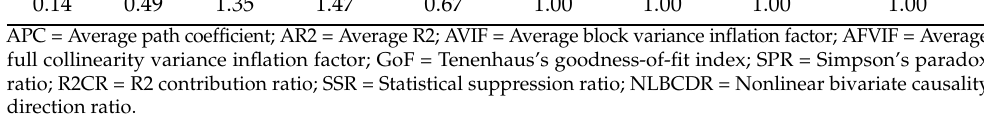
Table 2. Model quality and goodness-of-fit statistics for the structural equation model of intention to avoid driving into floodwater. APC AR2 AVIF AFVIF GoF SPR R2CR SSR NLBCDR 0.14 0.49 1.00